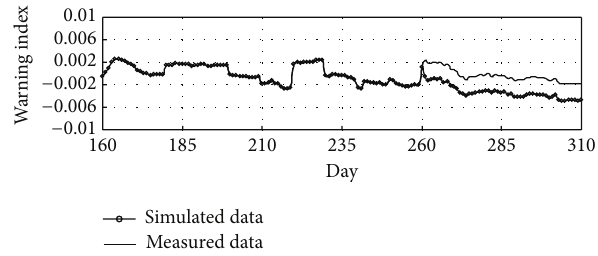
Figure 8: Measured waring index curve and simulated warning index curve due to the deterioration of the bridge using PCA method.